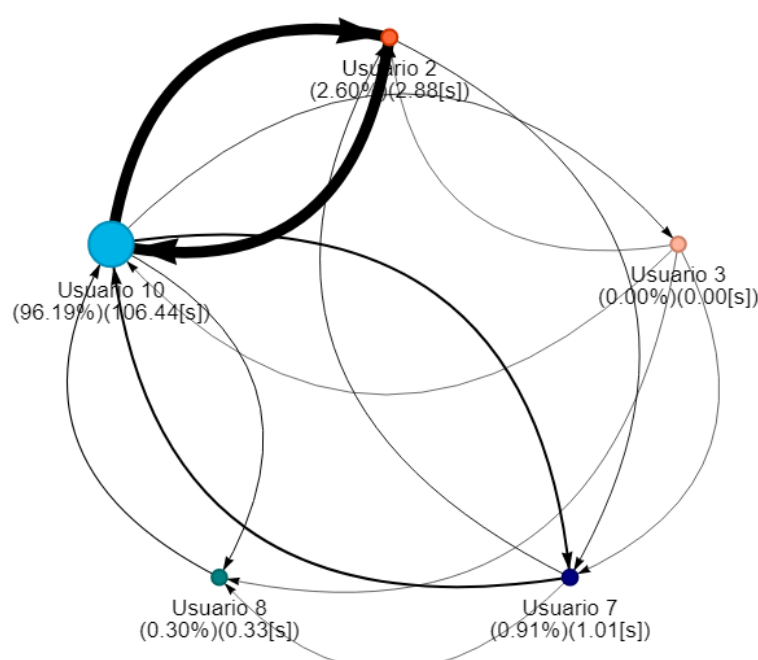
Figure 8. Problem detection with